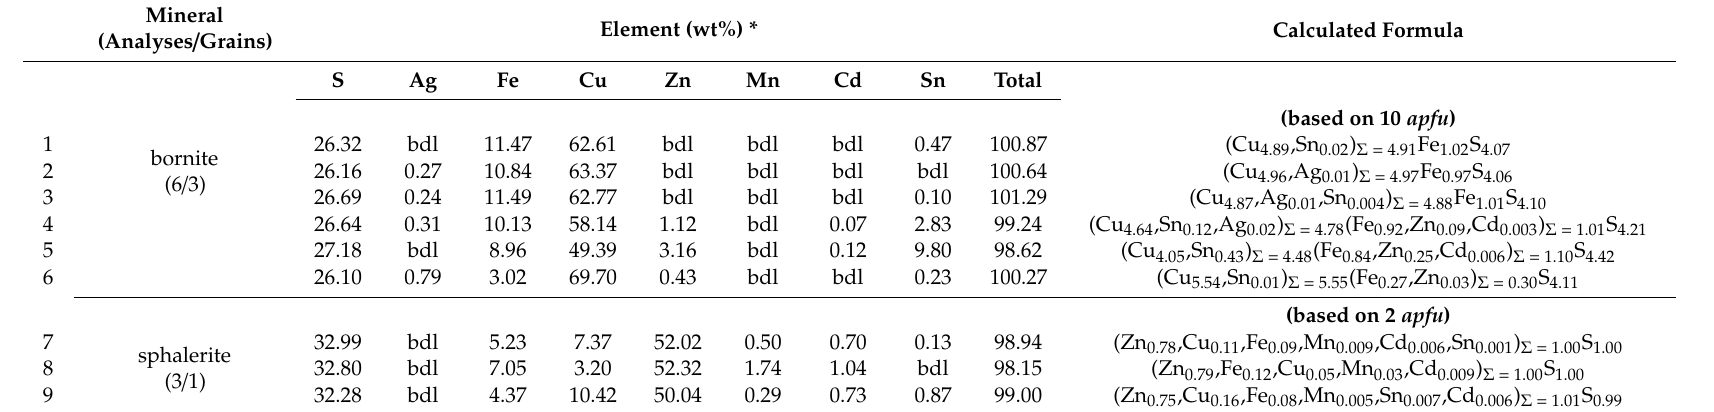
Table 1. Quantitative chemical data (wt%) for bornite and sphalerite from the Blidar Contact